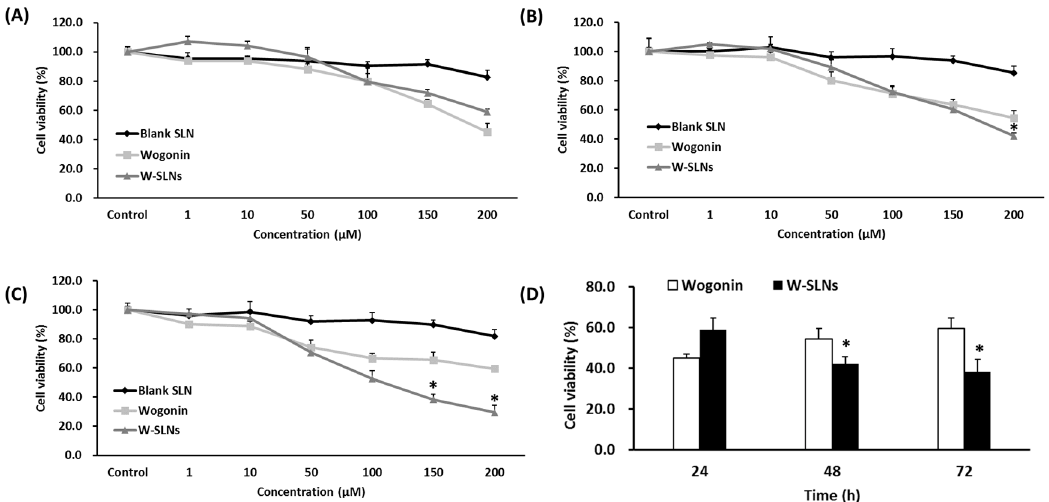
Figure 4. Cell viability of MCF-7 cells treated with different concentrations of blank SLN, wogonin, and W-SLN for ( A ) 24 h; ( B ) 48 h; and ( C ) 72 h. Cell viability of MCF-7 cells treated with 200 µM wogonin or W-SLN for 24, 48, and 72 h ( D ). * p > 0.05 shows a significant difference from wogonin.